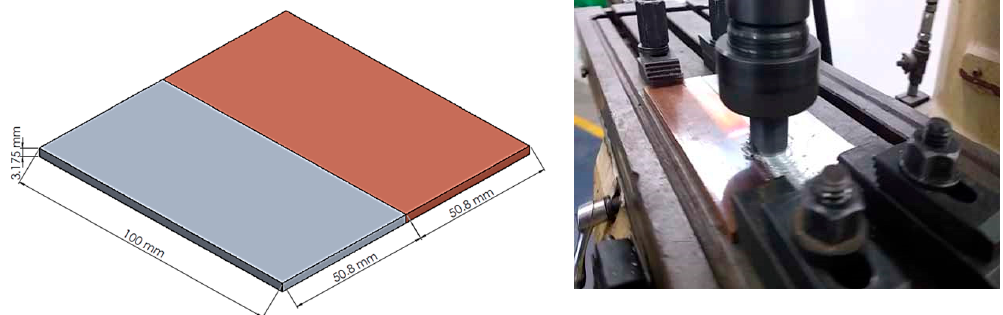
Figure 1. Dimension and configuration of Al6061-T6 and C1100 plates to be weld. Table 1. Chemical composition of base materials. Element